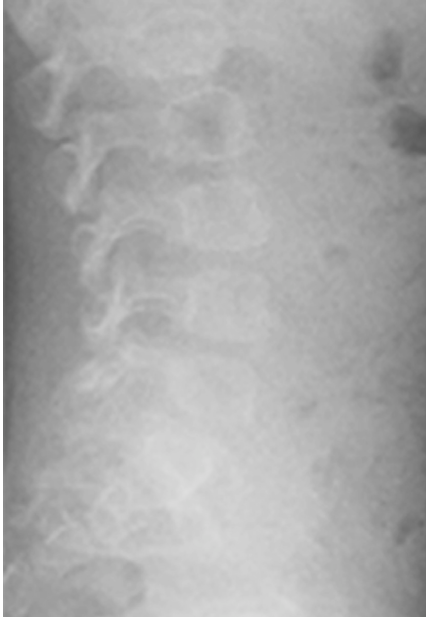
Figure 6: Chest X-ray image revealing egg-shaped vertebra.